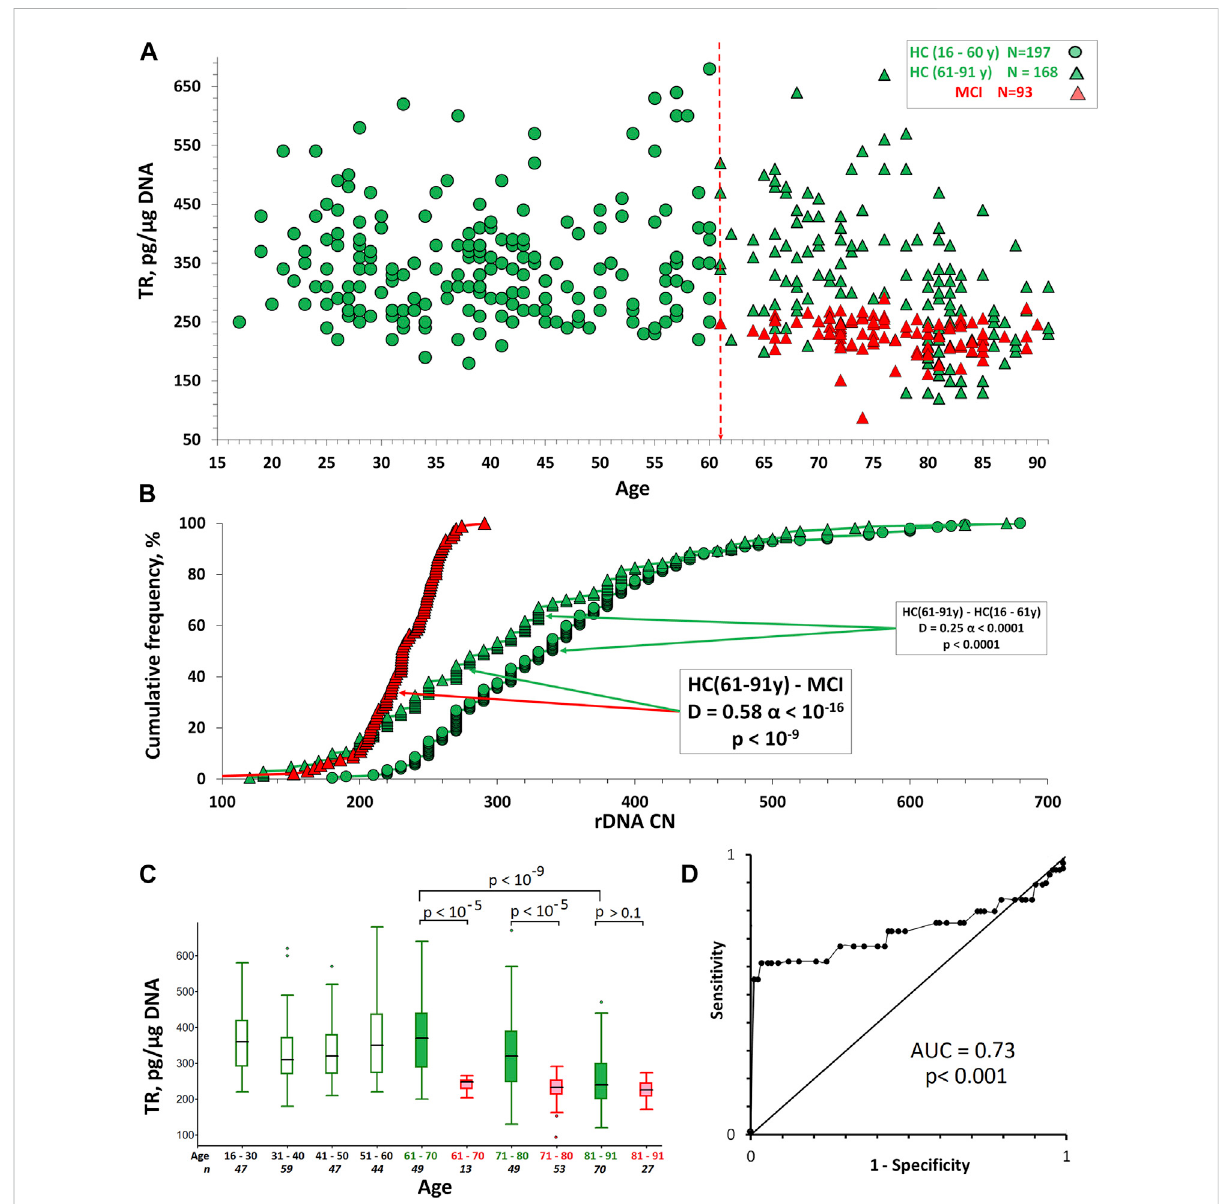
FIGURE 2 The TR content in the DNA of HC and MCI groups. (A) TR content dependence on human age. (B) Cumulative distributions of DNA samples by the TR content in the studied groups. The arrows indicate the distributions being compared. The data of the Kolmogorov-Smirnov (D and α ) and Mann-Whitney (p) test are presented in the boxes. (C) A box plot showing the TR content distribution for each age group. The groups were divided into smaller subgroups, about 10 years apart. (D) ROC curve for the HC (61 – 91y) and MCI